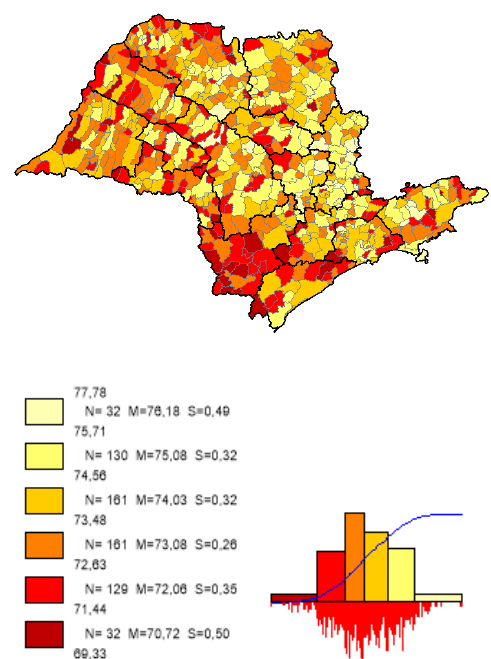
Figure 4. Distribution map of potential years of life gained in the municipalities of the State of Sao Paulo, DEA method. Note: Choropleth maps, consisting of six divisions, using the following limits—minimum value; 5th percentile; 25th, 50th and 75th percentiles; 95th percentile and maximum value. For each interval, the number (N) of municipalities, their mean (M) and standard deviation (S) are described. The histograms contain bars proportional to the number of localities in each division ( Philcarto images).